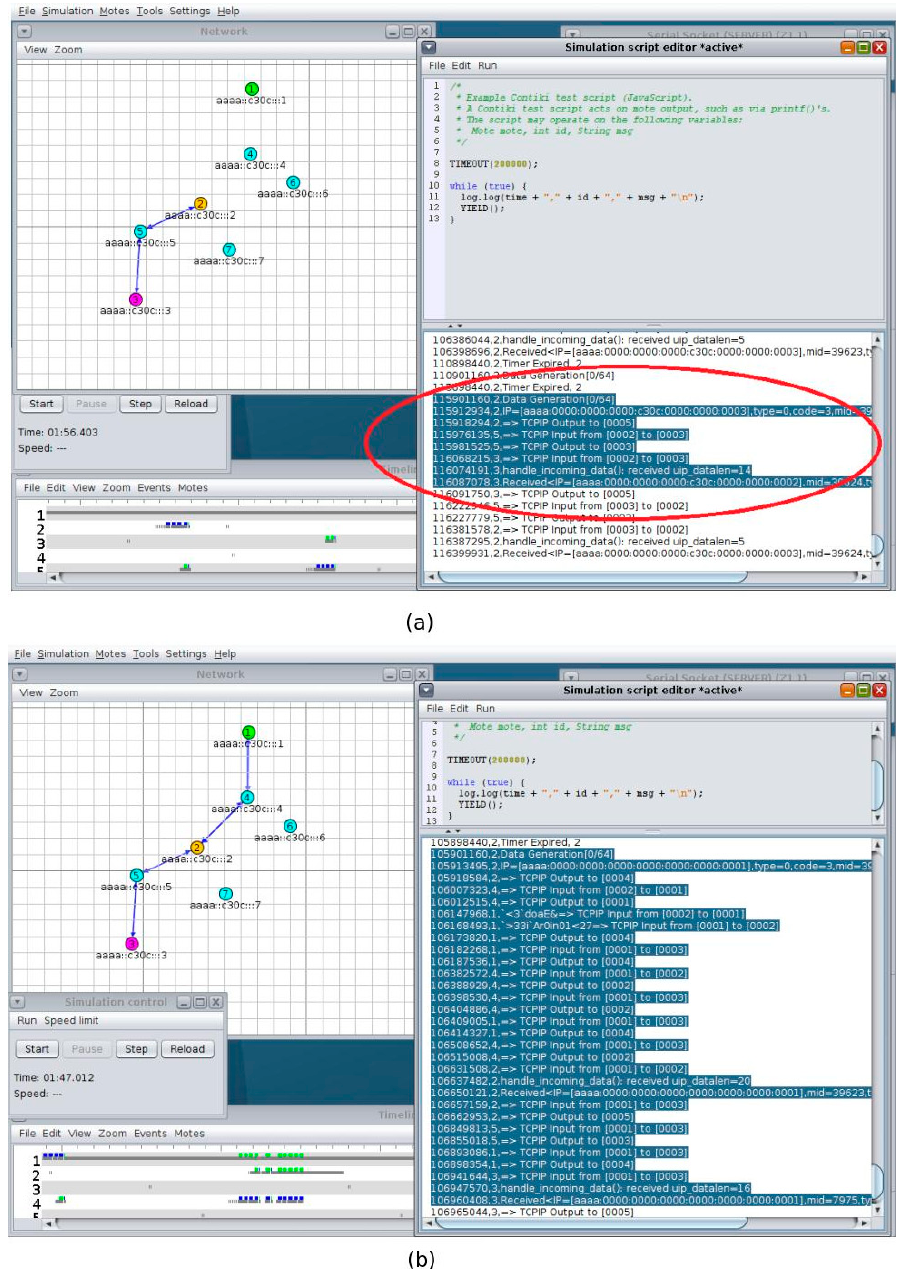
Figure 17. Sensor-Actuator Interactions. ( a ) Binding ( b ) Gateway/Cloud-Based Solution.